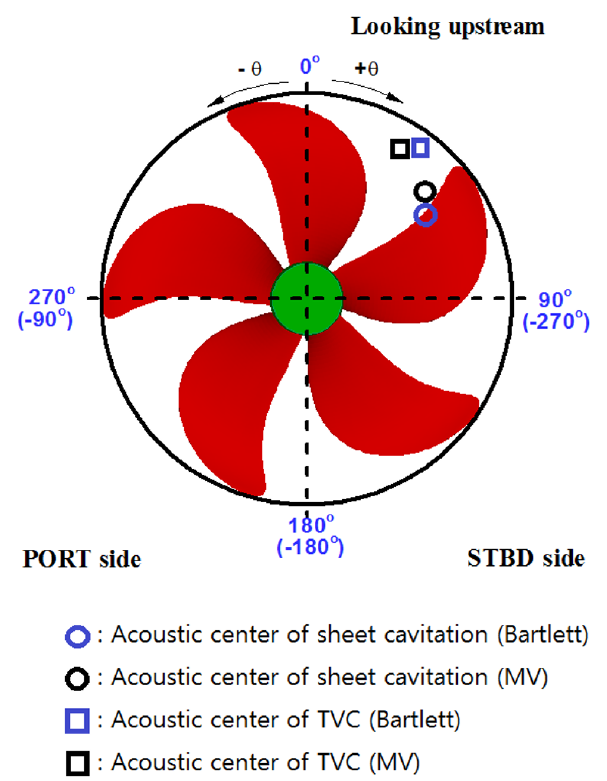
Figure 13. Notation of the blade angular position for the right-handed propeller when looking upstream. The estimated acoustic centers are also shown as circles (O) for the sheet cavitation and as squares ( □ ) for the tip vortex cavitation. (TVC: tip vortex cavitation, STBD: starboard).